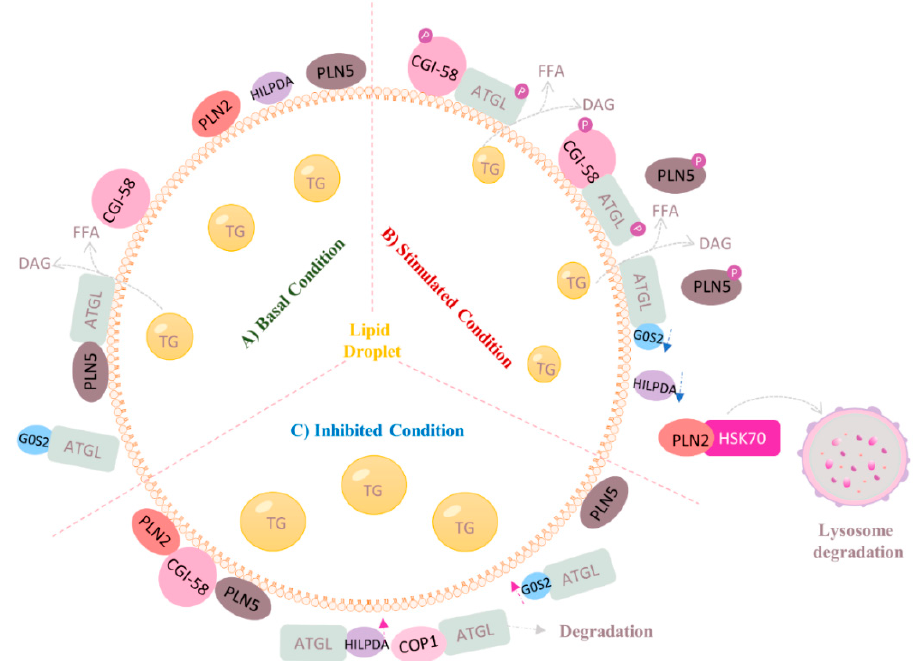
Figure 3. Regulation of ATGL at post-translational level in the liver. ( A ) In basal condition: LDs are coated with PLN2 and PLN5, which restrain the access of ATGL to the stored TGs. PLN5 also directly binds to ATGL, competing against CGI-58 for ATGL interaction. ( B ) In stimulated condition, PKA-mediated phosphorylation of PLN5 results to the release of ATGL and subsequently the co-activation by CGI-58. PLN2 is degraded through chaperone-mediated autophagy, which exposes the surface of LDs to ATGL, therefore stimulating lipolysis. ( C ) In inhibited condition: ATGL inhibitors HILPDA and G0S2 are upregulated, which enhances the inhibitory control over ATGL. E3 ubiquitin ligase COP1-mediated proteasomal degradation reduces the protein levels of ATGL, hence inhibiting lipolysis.